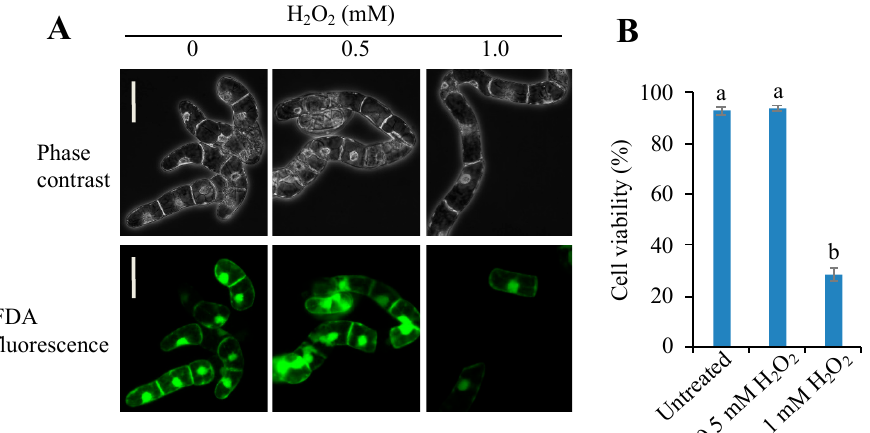
Figure 1. E ff ects of H 2 O 2 concentration on the viability of Bright Yellow-2 (BY-2) cells. A 0.5 mL aliquot of cells from 7-d culture were sub-cultured in 50 mL of fresh culture medium and, after 4 d, the culture medium was supplemented with H 2 O 2 to 0.5 mM or 1 mM. After 5 h incubation cells were harvested and stained with fluorescein diacetate (FDA). Living cells and dead cells were counted as described in the Materials and Methods section. Cells forming a single layer under microscopy were chosen for evaluation. ( A ) Typical phase-contrast (top) and FDA-fluorescence (bottom) images of the same field. Bar = 50 µ m. ( B ) Percentage of cell viability. The total number of cells was counted under phase contrast observation, and the FDA-stained cells were counted under fluorescence observation. A total of 200 cells were observed in each treatment. Means ± SE of three independent experiments are shown. Di ff erences among treatments were analyzed by Tukey’s test: p < 0.05. Di ff erent letters among the treatments represent statistically significant differences.